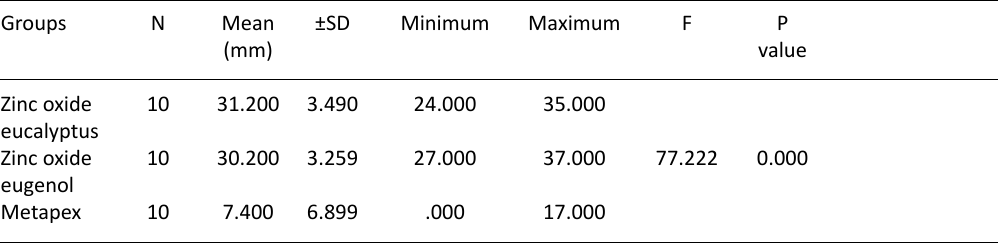
Table 5. Mean value of inhibition zones of obturation materials against C. albicans in millimeter Groups N Mean ±SD